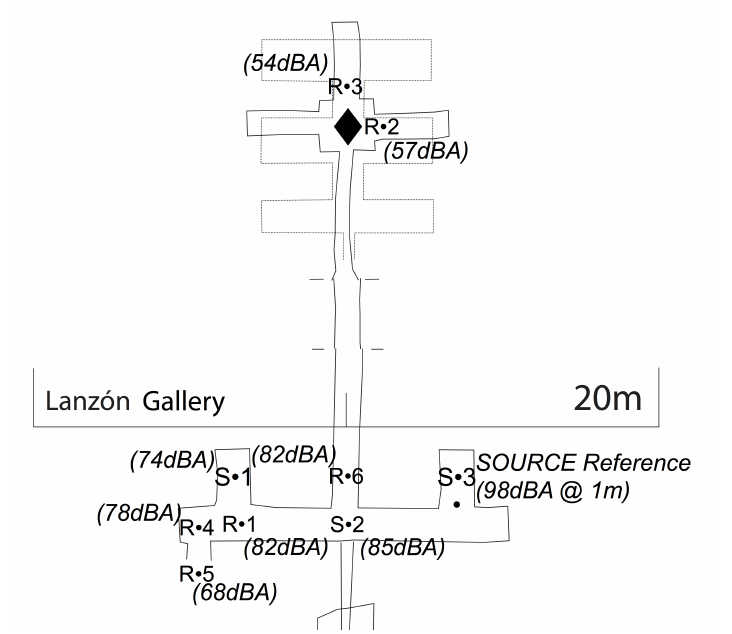
Figure 6. Mapped locations of sound-level measures (peak dB-SPL, A-weighted) of broadband noise in the Lanzón Gallery at Chavín, from directional source (Meyer MM-4XP single-driver loudspeaker) at average human head-height for ecological validity with speech communication. Reference mea- surement 98 dBA@1 m on-axis from the loudspeaker (floorplan from [49]). Analysis charted in Table 4 (below). 3D model of gallery shown in Figure 3